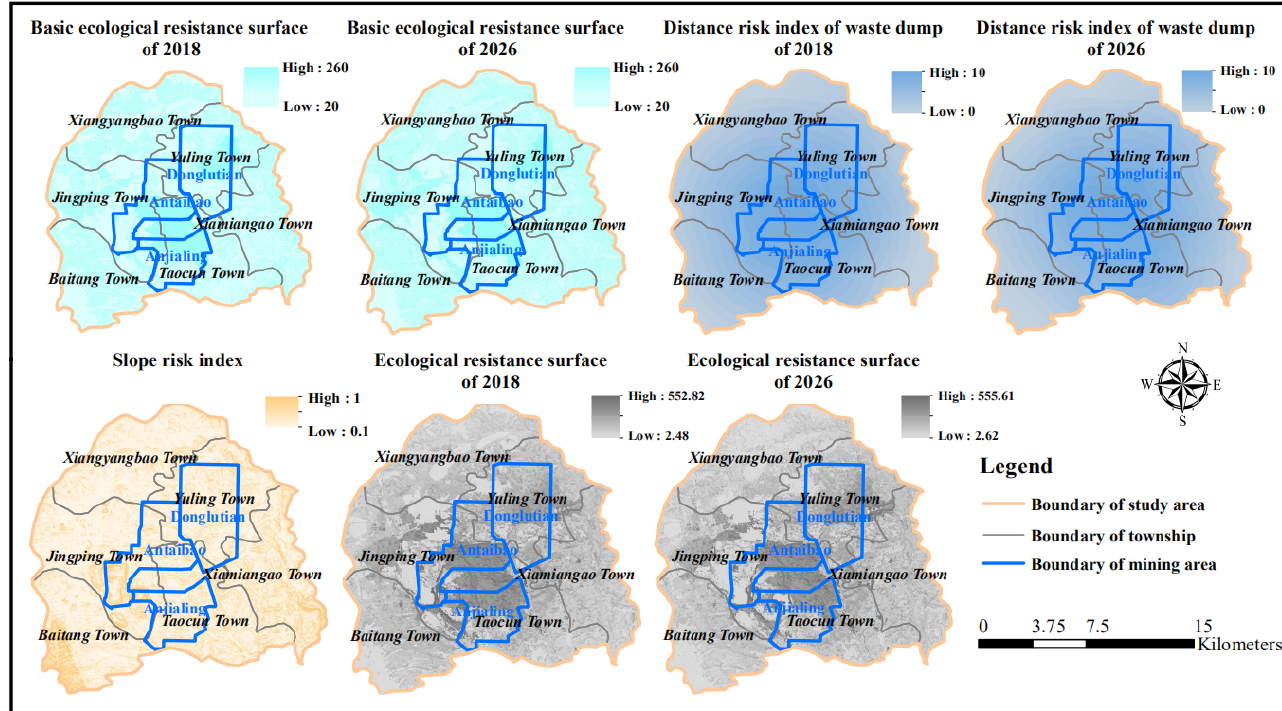
Figure 7. Spatial patterns of ecological resistance surface.